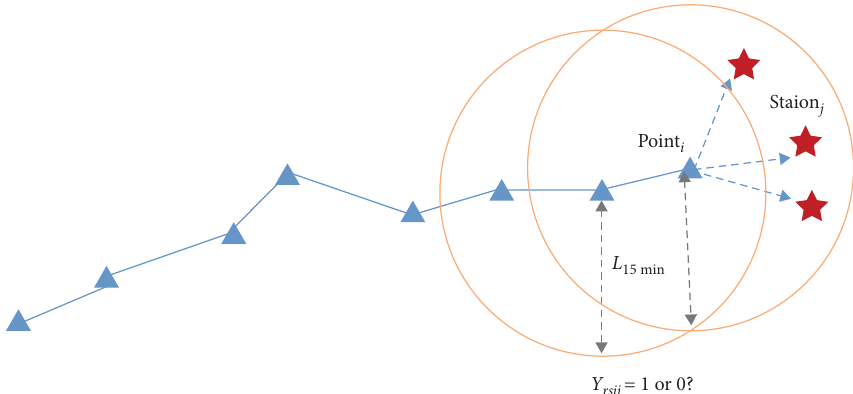
Figure 1: Diagram of return demand prediction and destination station